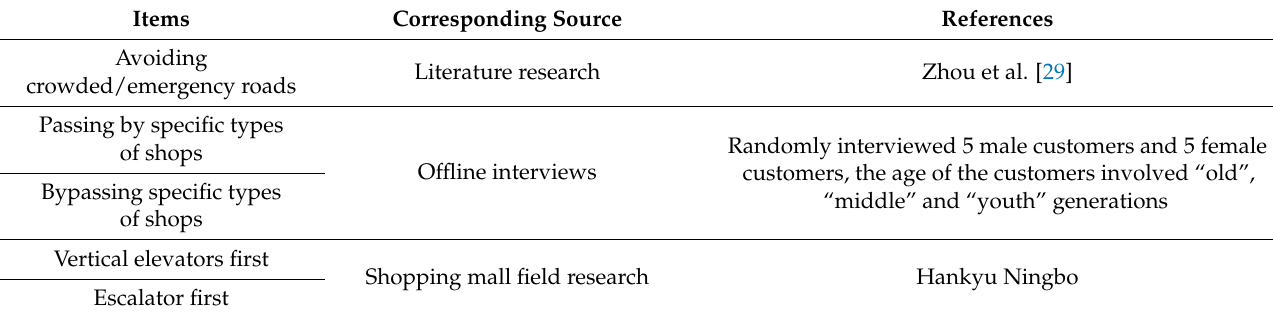
Figure 3. Main parts and specific items of questionnaire. Table 3. Source of 5 general